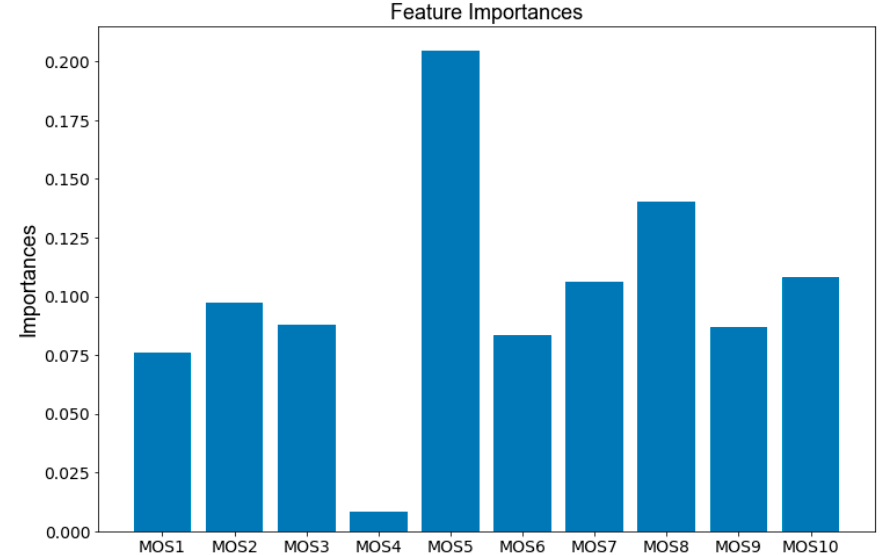
Figure 10. Importance ranking of each sensor in the E-nose.